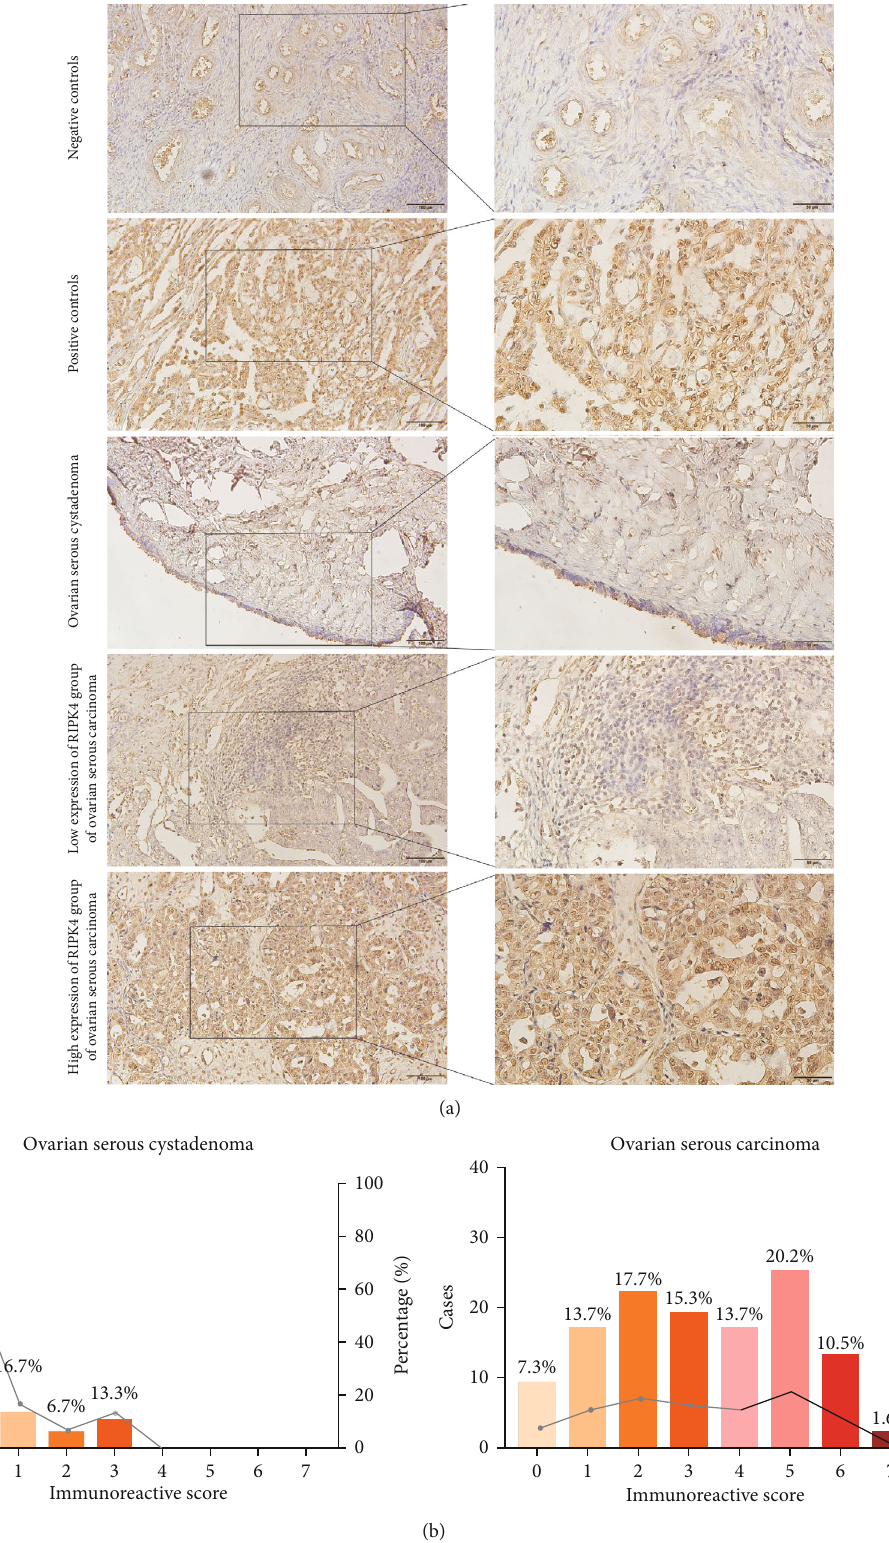
Figure 2: The expression of RIPK4 in protein level is available for all 154 cases. (a) IHC analysis shows that RIPK4 in cellular plasma is signi fi cantly higher in ovarian serous carcinoma than in ovarian serous cystadenoma tissues ( P < 0 : 001 ). Besides, we present the isotype antibody staining in normal ovary as negative controls and ovarian serous carcinoma as positive controls. (b) RIPK4 immunoreactive scores for individual patients are